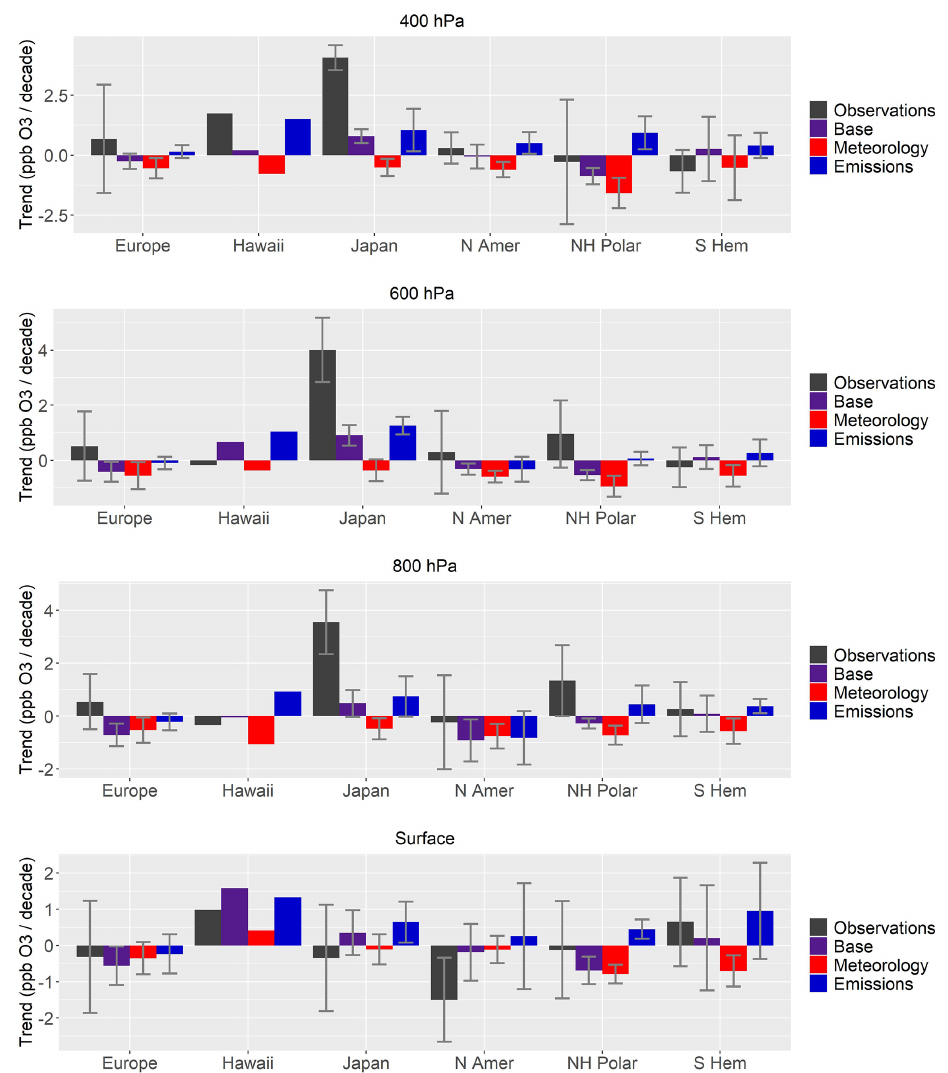
Figure 11. Trends in tropospheric ozone in observations and in GEOS-Chem at four pressure levels (surface, 800, 600, and 400hPa) from 1990–2017, averaged over six regions. Observed ozonesonde trends at 25 ozonesonde sites and 271 surface sites (black bars) are compared with the base GC 4 ◦ × 5 ◦ simulation (purple bars), the “Meteorology” simulation with constant emissions (red bars), and the “Emissions” simulation with constant meteorology (blue bars). Thin gray bars denote the standard deviation across